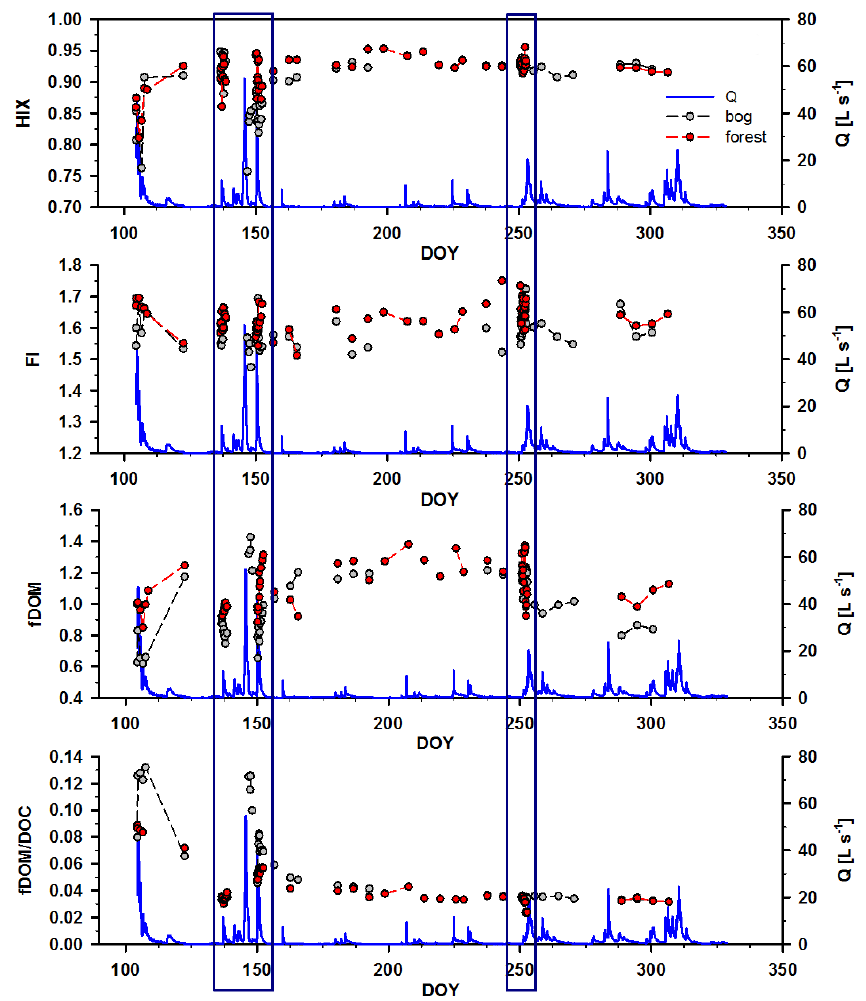
Figure 4. Annual record of the humification index (HIX), fluorescence index (FL), sum of all Fmax PARAFAC components values (fDOM) and fDOM to DOC concentration (mgL − 1 ) ratio against day of the year (DOY) in 2013. The blue line represents the bog discharge ( Q ). Grey circles represent the bog site, red circles the forested site. Sampled rain events in spring and fall are